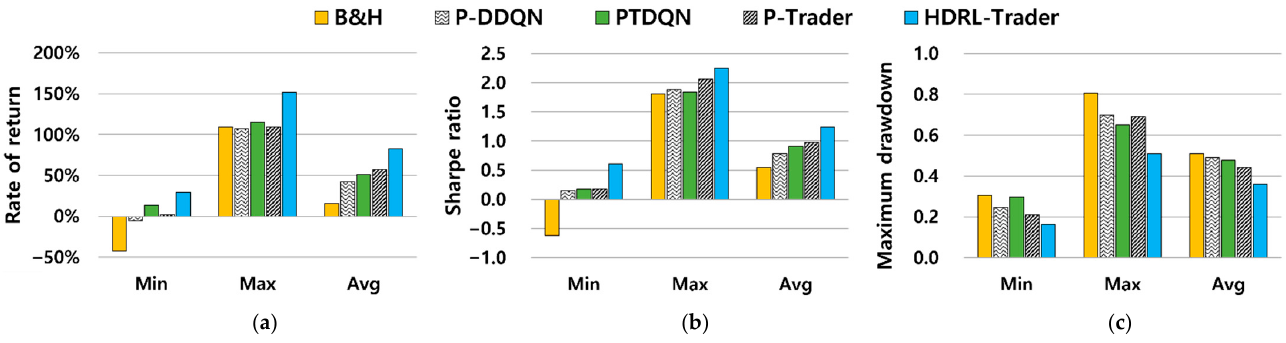
Figure 12. Experimental results on the larger dataset. ( a ) Rate of return. ( b ) Sharpe ratio. ( c ) Maximum drawdown.